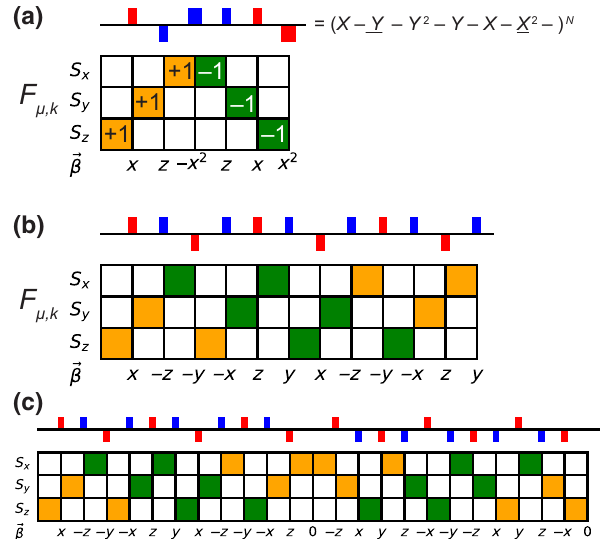
FIG. 12. Pulse sequences. In each part of the figure, the top shows the sequence in the laboratory frame [following Figs. 6(b) and 6(c)], while the bottom shows F μ , k in the graphical nota- tion of Ref. [53]. The k th column gives the value of F μ during the k th toggling frame, with +1 ( − 1) entries shown in orange (green). The very bottom gives the toggling-frame rotation axis (cid:7) β k connecting the frames. (a) Sequence 1. (b) Sequence 2. Impor- tantly, the toggling-frame Hamiltonian is perfectly periodic: F μ , k has period T for all μ , | F μ , k | has period T / 4 for all μ , and has period T / 2. (c) Sequence 3, which consists of sequence 2 with its inverse appended. Each half maintains the periodicity of sequence